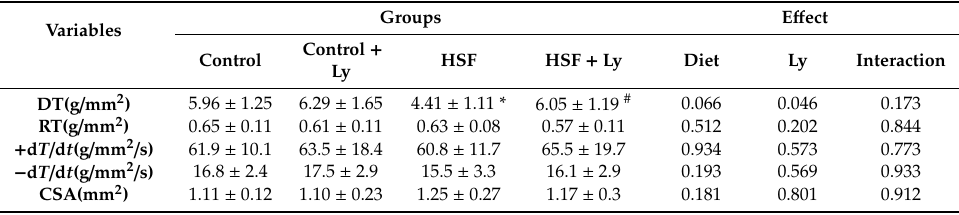
Table 3. Isolated papillary muscle at baseline condition (2.5 mM Ca 2 + ).